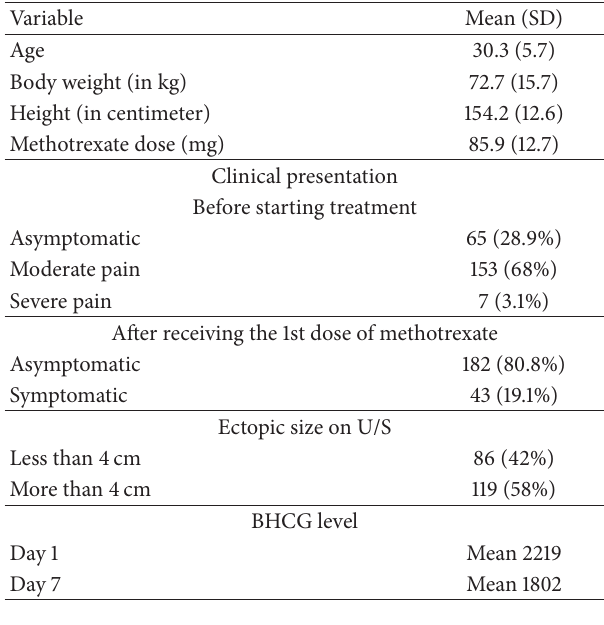
Table 1: Baseline characteristics.